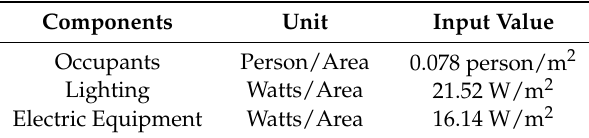
Table 5. Cooling schedules for internal heat load.